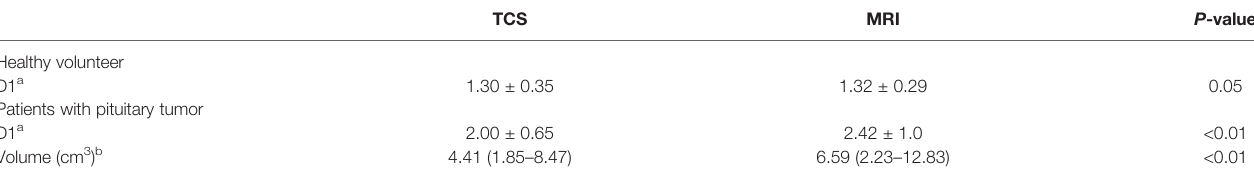
TABLE 2 | Comparison of measurements between transcranial sonography (TCS) and